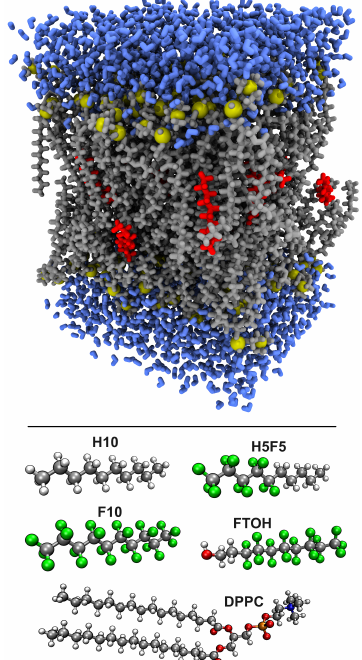
Figure 4. Upper panel: Snapshot of one of the simulation cells (gray: dipalmitoylphosphatidylcholine (DPPC) C/H/O atoms; yellow: DPPC N/P atoms; red: n -decane; blue: water). Lower panel: Molecular structures of the molecules involved in this